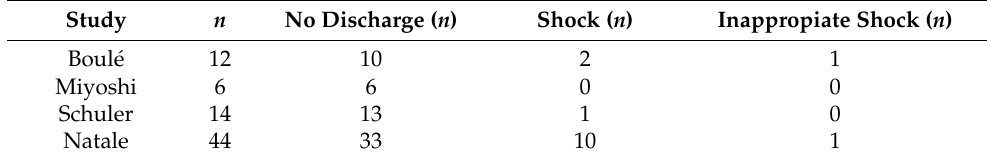
Table 6. Highlight the risk of appropriate and inappropriate shocks in pregnant women with an